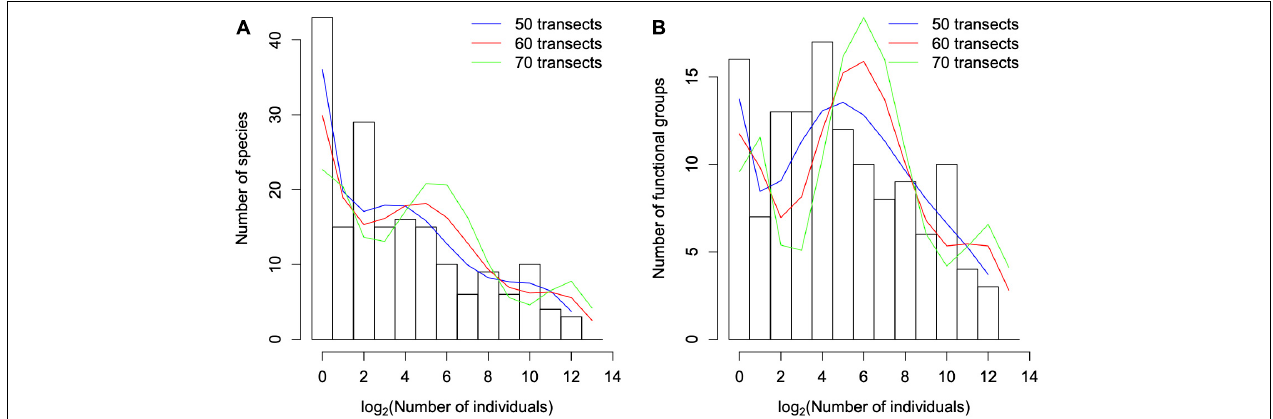
FIGURE 5 | The histograms correspond to the species (A) and functional units (B) abundance distributions of the arthropod species for Terceira’s 39 transects, and as a reference, the extrapolations to 50, 60, and 70 transects are plotted in the blue, red, and green lines, respectively. Notice, in both cases, the reduction in the number of singletons when the number of transects increases. For the species abundance distribution there is a clear development of a peak for intermediate classes, while for the functional units such a peak is already present for 39 transects, but it increases when the number of transects